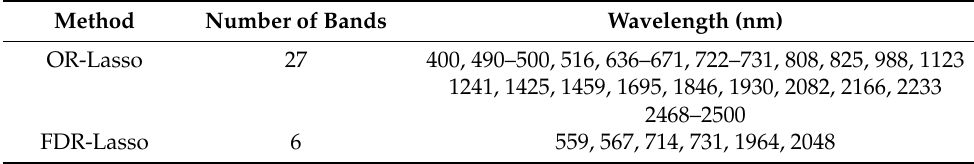
Table 5. The prediction model ’ s outcome statistics.